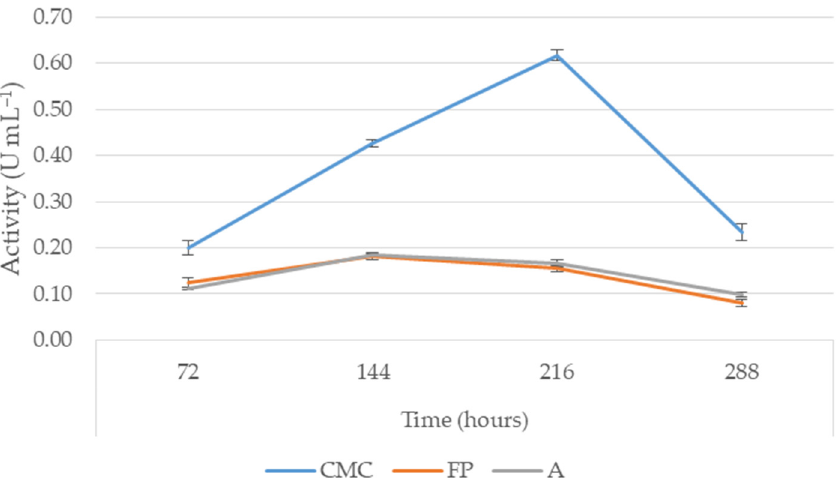
Figure 1. CMCase production of Bacillus sp. 8E1A with various sources of cellulose.